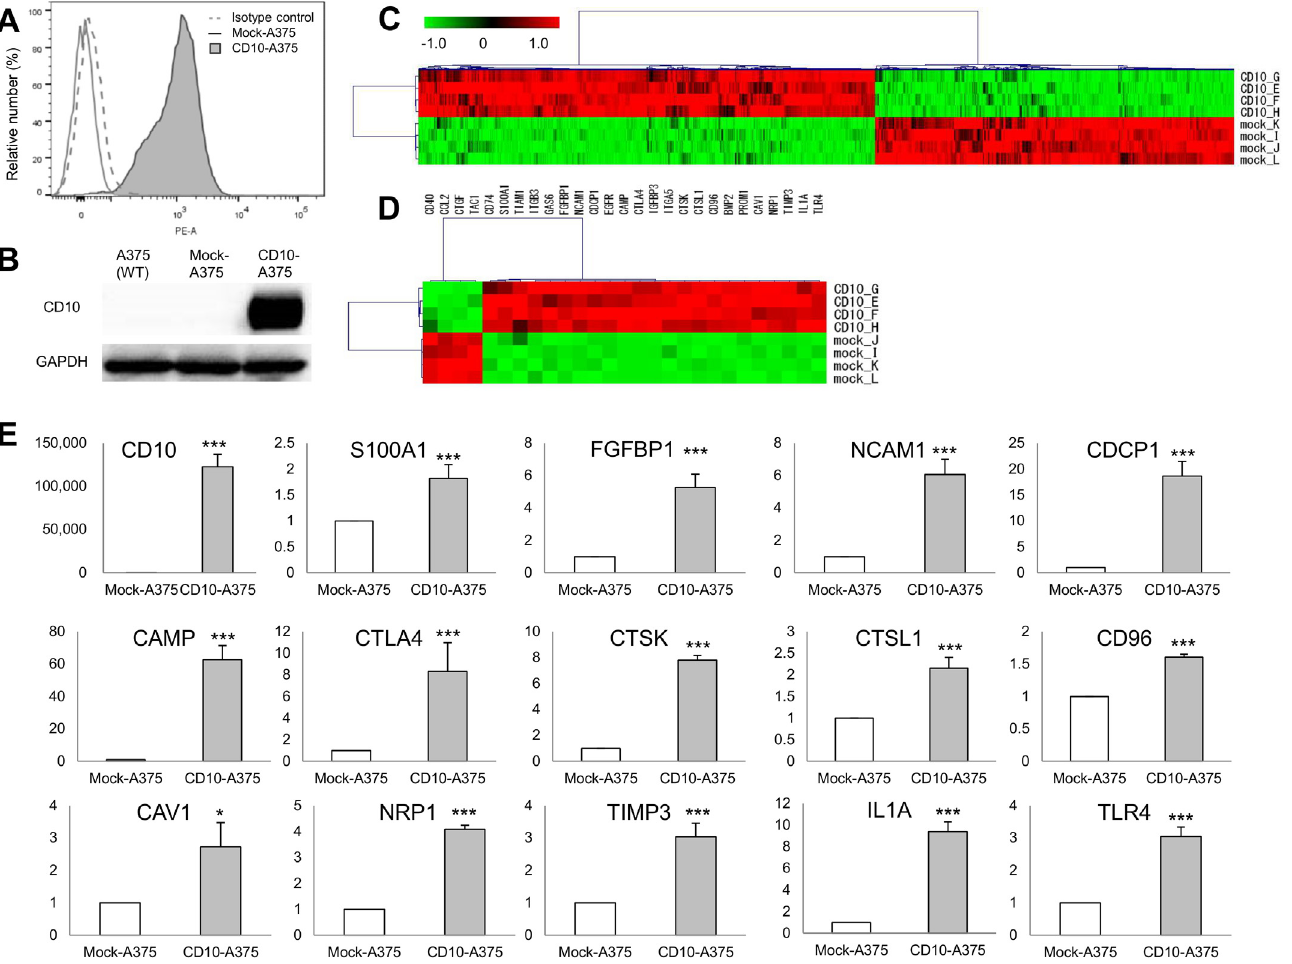
Fig 1. Establishment of CD10-A375 melanoma cells and gene expression profiles. (A) Stable transfection of CD10-A375 cells was confirmed by flow cytometry. After selection with G418, CD10-A375 or mock-A375 cells were examined for CD10 protein expression with PE-conjugated anti-hCD10 antibody. CD10-A375 exhibited marked surface expression of CD10 (gray shaded area), whereas mock-A375 did not (solid gray line). Isotype IgG control is shown with a gray dashed line. (B) Western blot analysis of CD10 and GAPDH in the wild type- and transfected- A375 cells. Successful transfection of CD10 was also confirmed in CD10-A375 cells by Western blot analysis. (C and D) Microarray analysis of gene expression in CD10-A375 vs. mock-A375 melanoma cells. (C) Heat map generated using MeV4.6 from the 1,247 probes of genes significantly differentially expressed between CD10-A375 and mock-A375 ( n = 4 per group). A red color represents a higher-than-average standardized expression value, whereas a green color represents a lower-than-average one. Examples of differentially expressed genes are listed and sorted into major known functional categories in Table 2. (D) Heat map of the selected genes as shown in Table 2. (E) qRT – PCR validation analysis of representative genes that were significantly upregulated in CD10-A375 ( n = 3). Each value was normalized for ACTB ( β -actin), and the results are expressed as fold change over mock-A375. Primers used in the assay are shown in Table 2. * P < 0.05, ** P < 0.01, *** P < 0.001; unpaired t